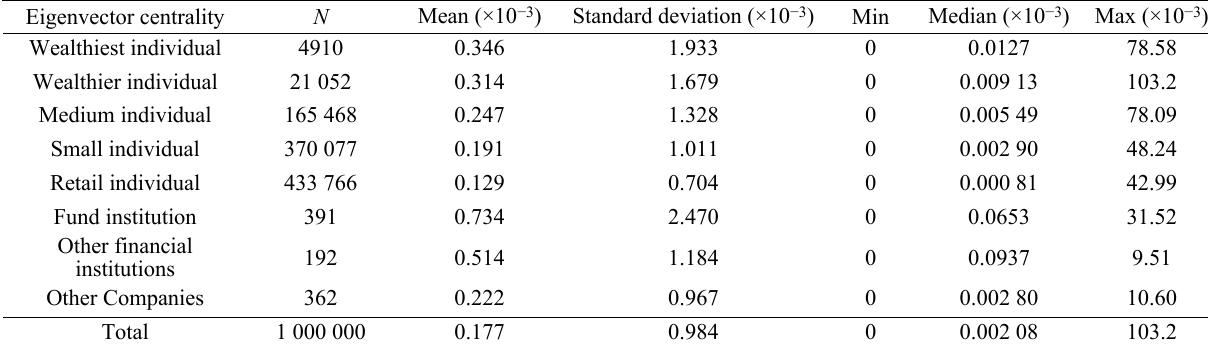
Table 9 Descriptive statistics of eigenvector centrality of